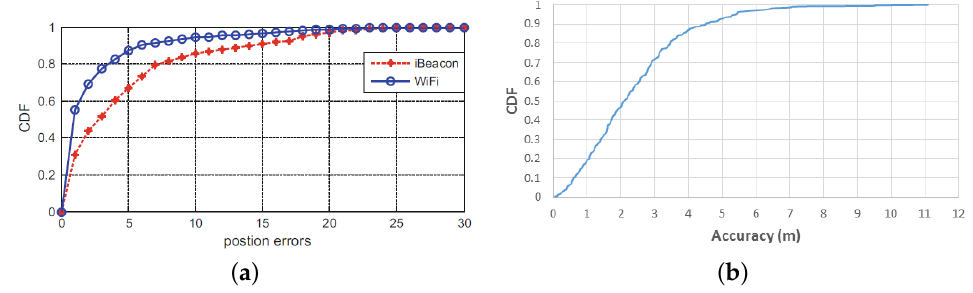
Figure 16. Comparison of CDF between a previous study and this paper: ( a ) CDF of positioning accuracy of iBeacons and WiFi APs [12]; and ( b ) CDF of our BLE-based